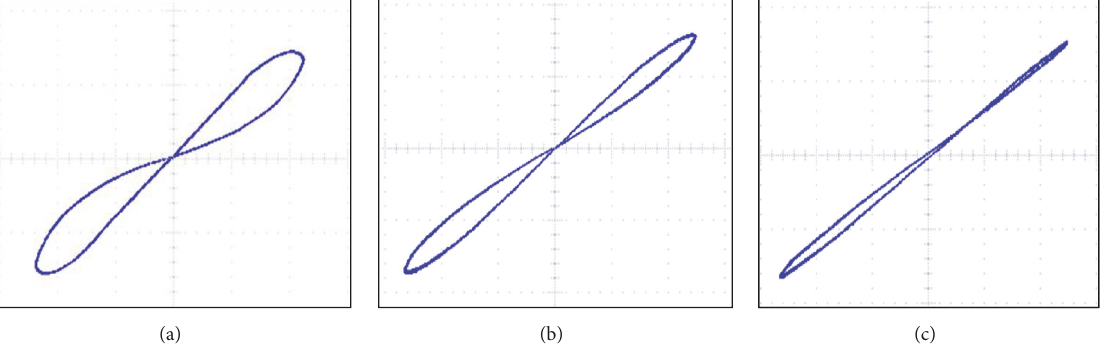
Figure 10: Experimental results of the decremental type emulator when 𝐶 1 = 𝐶 2 = 1 nF. (a), (b), and (c) represent hysteresis loops in V - 𝑖 plane operating at 1kHz, 5 kHz, and 10kHz, respectively. The scales are 0.2 V/div for 𝑥 -axis and 0.2 V/div for 𝑦